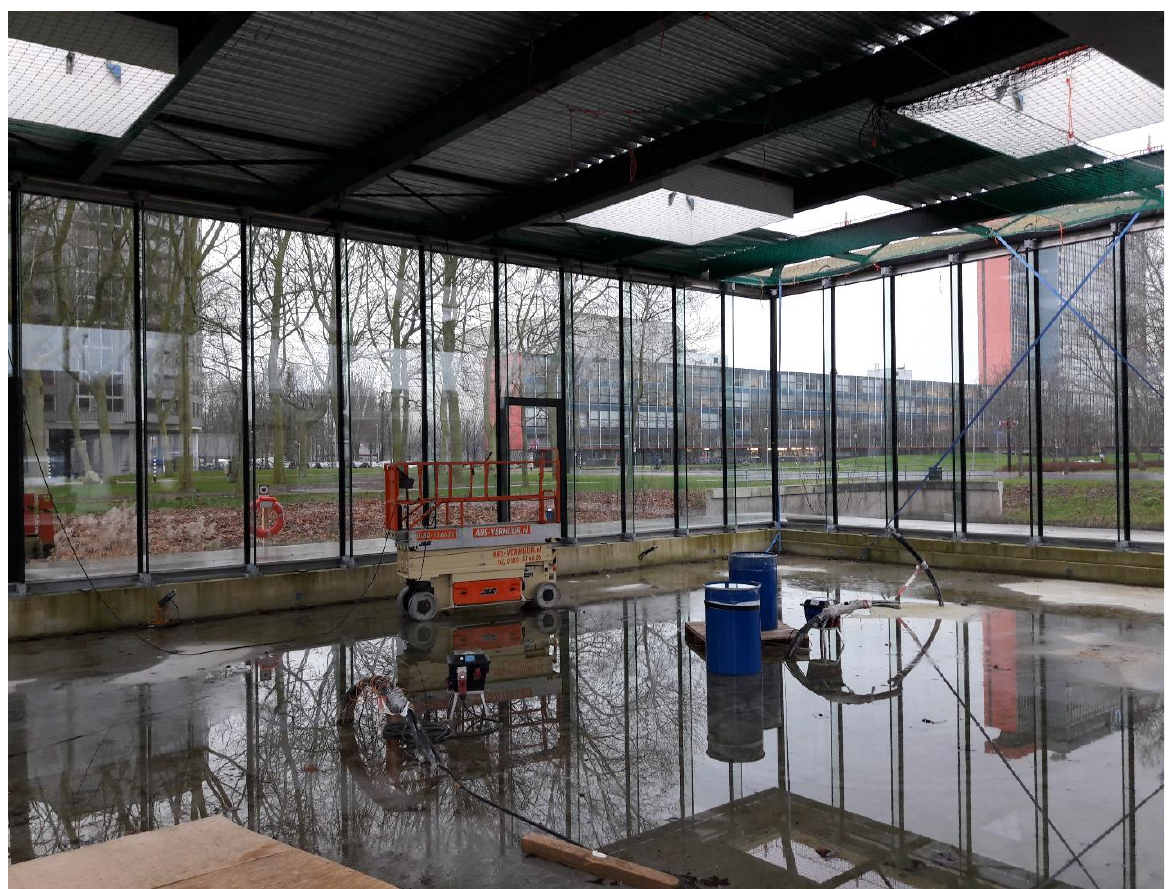
Fig. 12 Co Creation Centre during installation in January